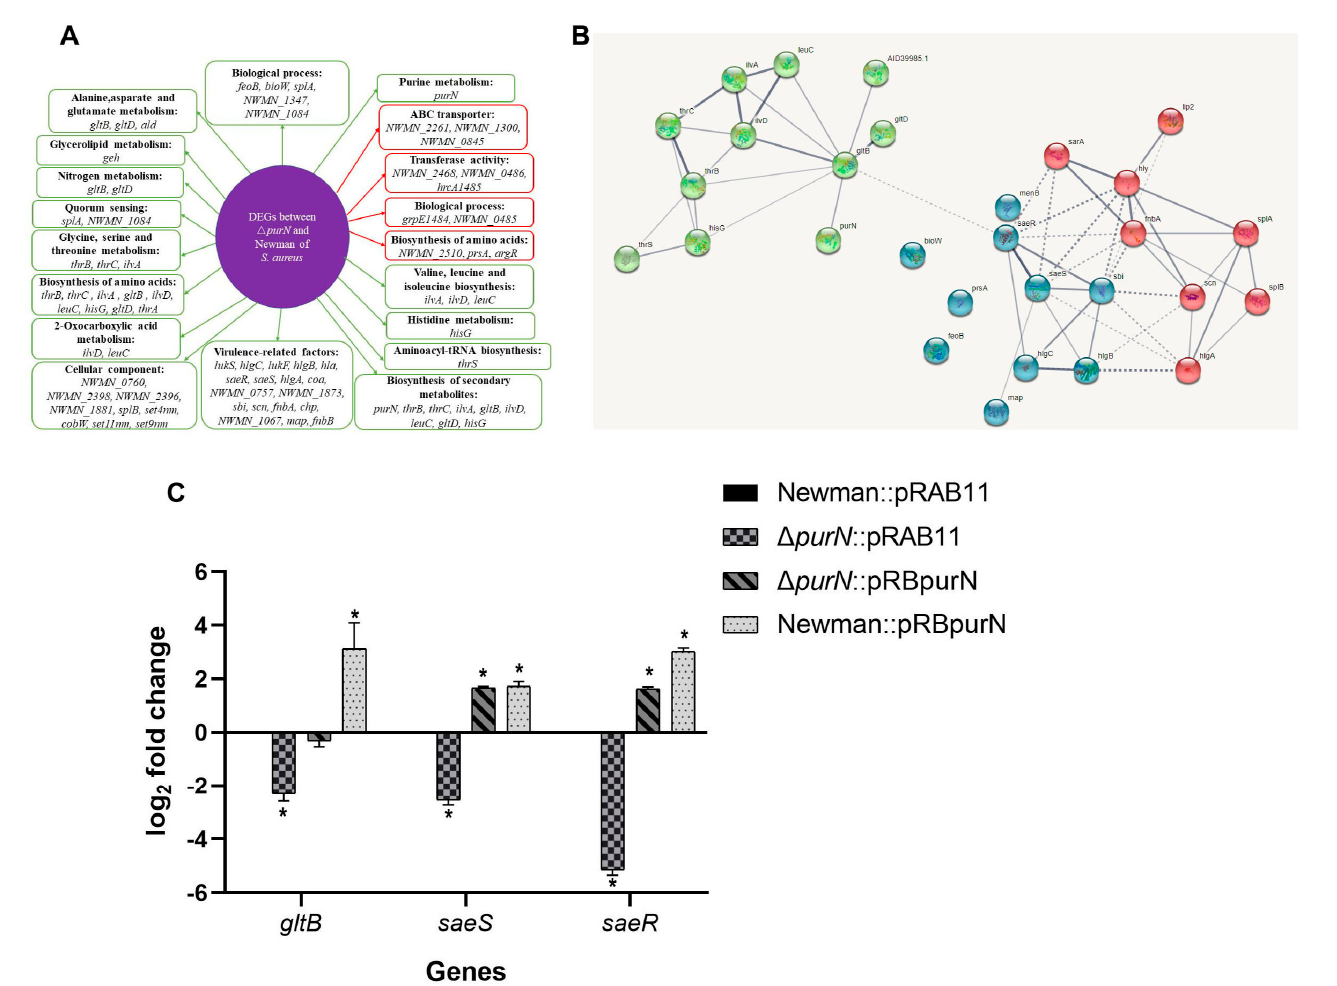
Figure 4. Comparative analyses of the transcriptomics of ∆ purN and wild-type, and the gltB , saeR , and saeS expression in Newman::pRAB11, ∆ purN ::pRAB11, ∆ purN ::pRBpurN, and Newman::pRBpurN strains. ( A ) DEGs and pathways involved in the comparison of ∆ purN and wild-type. The genes in the green box and red box are downregulated and upregulated genes, respectively. ( B ) Protein-protein interaction network of DEGs between ∆ purN and parental strain by STRING database. The line thickness of the network indicates the strength of association/binding. ( C ) Comparison of expression levels of the gltB , saeR , and saeS in the four S. aureus strains (* p <